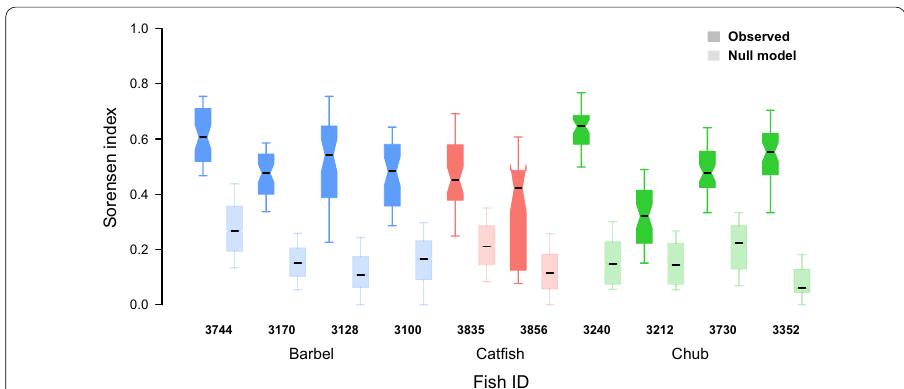
Fig. 6 Similarity between fish daily motifs. Boxplot of Sørensen index between fish daily motifs according to the fish and fish species. Results obtained with the null model are displayed in a brighter version of the baseline fish species color. The boxplot is composed of 45 comparisons for the observed motifs and 45*100 comparisons for the motifs obtained with the null model. Each boxplot is composed of the first decile, the lower hinge, the median, the upper hinge and the last